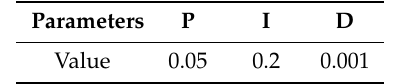
Table 4. Parameters used for step reference.